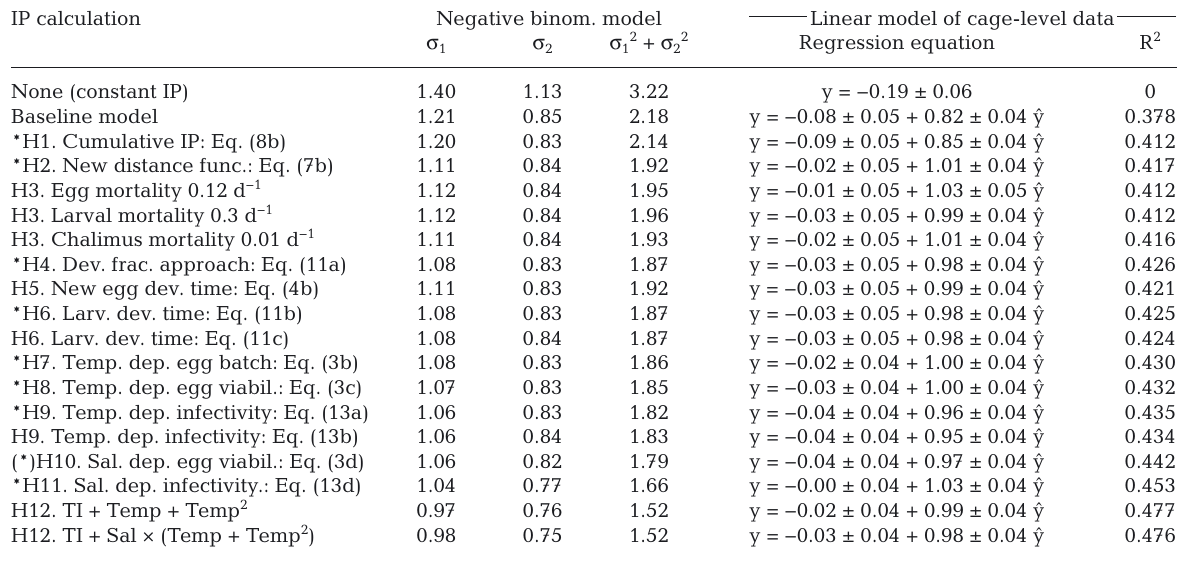
uncertainty caused by random variability between time periods, areas and cages, but not the uncer- tainty in model parameters. We calculated predic- tions from the baseline model, the final model, as well as from selected models from intermediate steps of the model selection. To measure predictive power, we calculated root-mean-squared prediction error (RMSE) and mean absolute prediction error (MAPE), both on scale . The statistical computing platform R version 3.61 (R Core Team 2019) was used for all analyses. The mixed-effects models were fitted using the ‘glmer.nb’ function in the R package ‘lme4’ version 1.1-21 (Bates et al. 2015). Table 1. Salmon lice model development. Lice counts for 2012−2017 were analysed in a negative binomial model as a function of ln-scale infestation pressure (IP) (n = 756 sentinel cages with a total of 18573 fish). The model included random effects of area−year−period and cage, with standard deviations σ 1 and σ 2 , respectively. At each step of the model development, we con- sidered the calculated IP to be more accurate if the unexplained variance ( σ 12 + σ 22 ) was reduced. The dispersion parameter was estimated to be θ = 15.3 for all models. An asterisk (*) implies that a hypothesis (H) was supported and the modification was applied to all subsequent models shown. An asterisk in parentheses for H10 means that the hypothesis was not supported when reassessed after applying the correction tested under H11 and hence not applied. The linear model analysed cage-level lice count data (observed versus predicted) for the same years, with the regression equation being unbiased if the intercept was near 0 and the slope near 1. R 2 was the amount of variance explained by the linear model. None: variation in lice counts without IP as a predictor in the negative binomial model. The baseline model used IP: Eq. (8a); distance function: Eq. (7a); total development time: Eq. (6); egg. dev.: Eq. (4a); egg mortality: 0.17 d −1 ; larval mortality: 0.17 d −1 ; and chalimus mortality: 0.001 d −1 . Total development time in the development fraction approach (Eq. 11a) initially used egg development time: Eq. (4a); larval development time: Eq. (11a). The last 2 rows show results when salinity (Sal) and temperature (Temp) were covariates to total infestation pressure (TI) in the negative binomial model (Eq. 9c). Temp was included as a quadratic term, either additively (Eq. 15a) or non-additively (Eq. 15b; shown by the symbol ×) to salinity. y = ln(mean observed salmon lice per fish in a cage + 0.033); ŷ = ln(predicted mean salmon lice per fish in a cage +